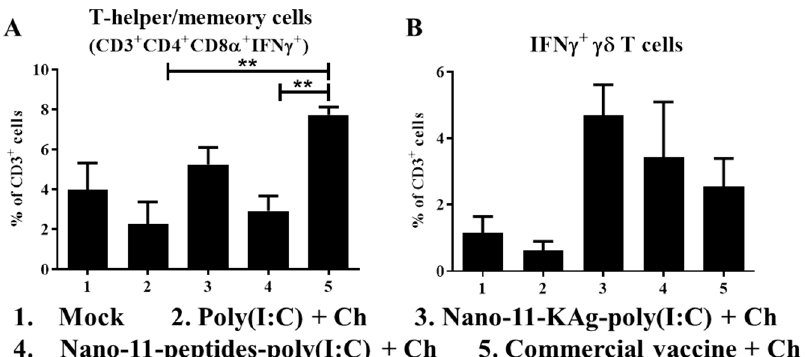
Figure 4. Recall IFN- γ secreting lymphocyte response in Nano-11 and commercial influenza vaccinated and virus challenged pigs. PBMCs isolated at post-challenge day six were stimulated with vaccine H1N2-OH10 SwIAV, immunostained and analyzed for the frequency of IFN- γ secreting ( A ) T-helper/memory cells (CD3 + CD4 + CD8 α + ); and ( B ) γδ T cells by flow cytometry. Data represent the mean value of four to five pigs ± SEM. Statistical analysis was carried out using one-way analysis of variance followed by Tukey’s post hoc comparison. Asterisk refers to statistical difference between the two indicated groups (** p < 0.01). Ch—Challenge.